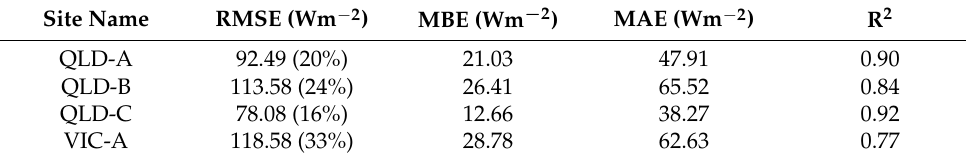
Table 4. Error metrics for modelled and observed GHI in the benchmarking period.